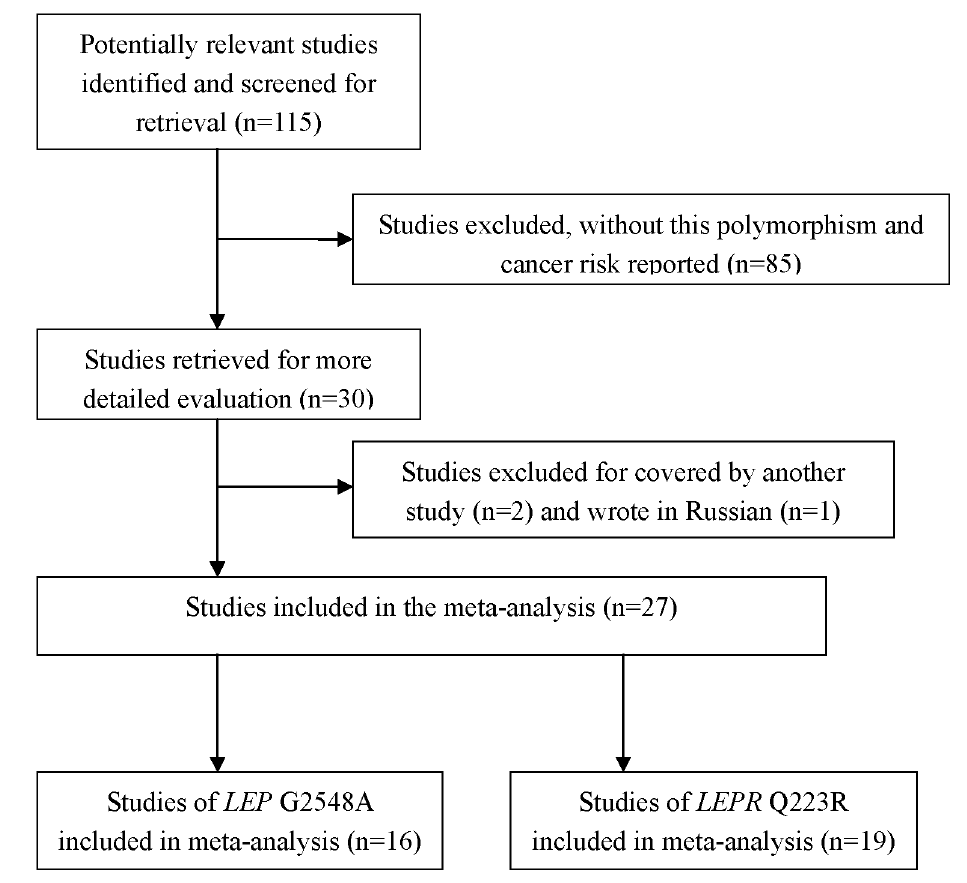
Figure 2. Flow chart of included studies for this